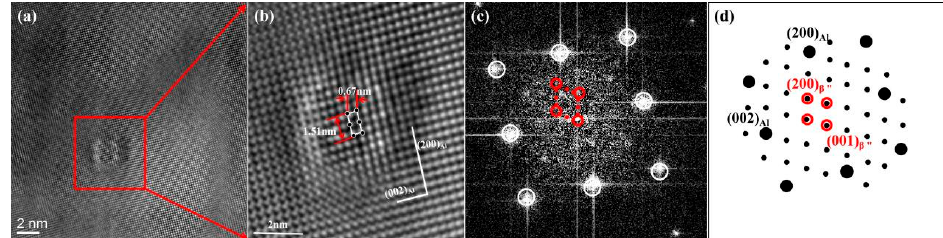
Figure 7. β″ phase in A2 alloy in the <010>Al axis after aging treatment: ( a ) TEM image, ( b ) HRTEM image, ( c ) corresponding FFT, ( d ) schematic pattern.